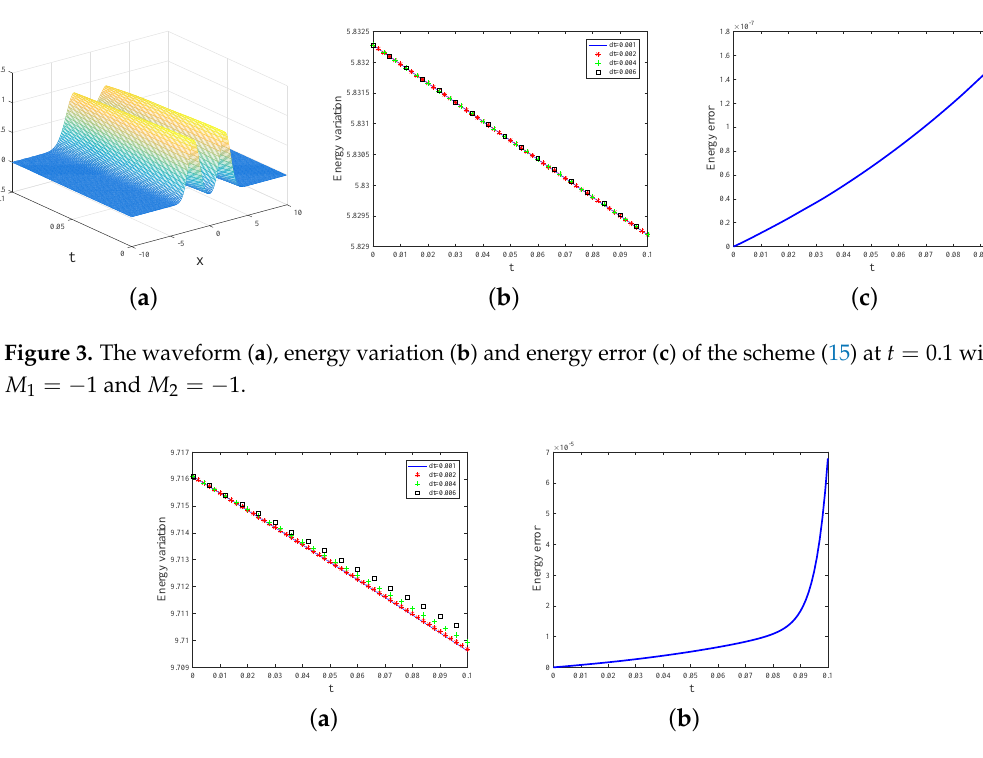
Figure 4. The energy variation ( a ) and energy error ( b ) of the scheme (15) at t = 0.1 with M 1 = − 0.2 and M 2 = −